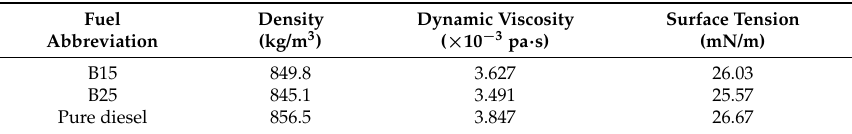
Table 1. Physical properties of the fuels (20 ◦